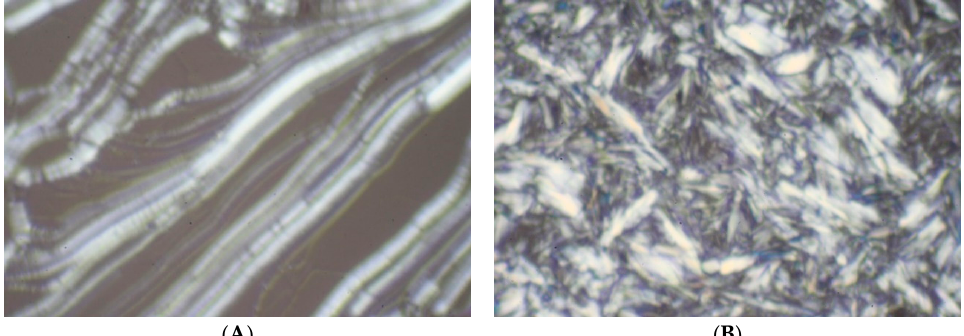
Figure 2. POM textures of ( A ) 4-n-dodecylbenzenesulfonic acid at 100 °C and ( B ) 4-n-octadecylbenzenesulfonic acid at 110 °C displying oily streaks and b â tonnets textures of SmA phases (magnification 400 ×).